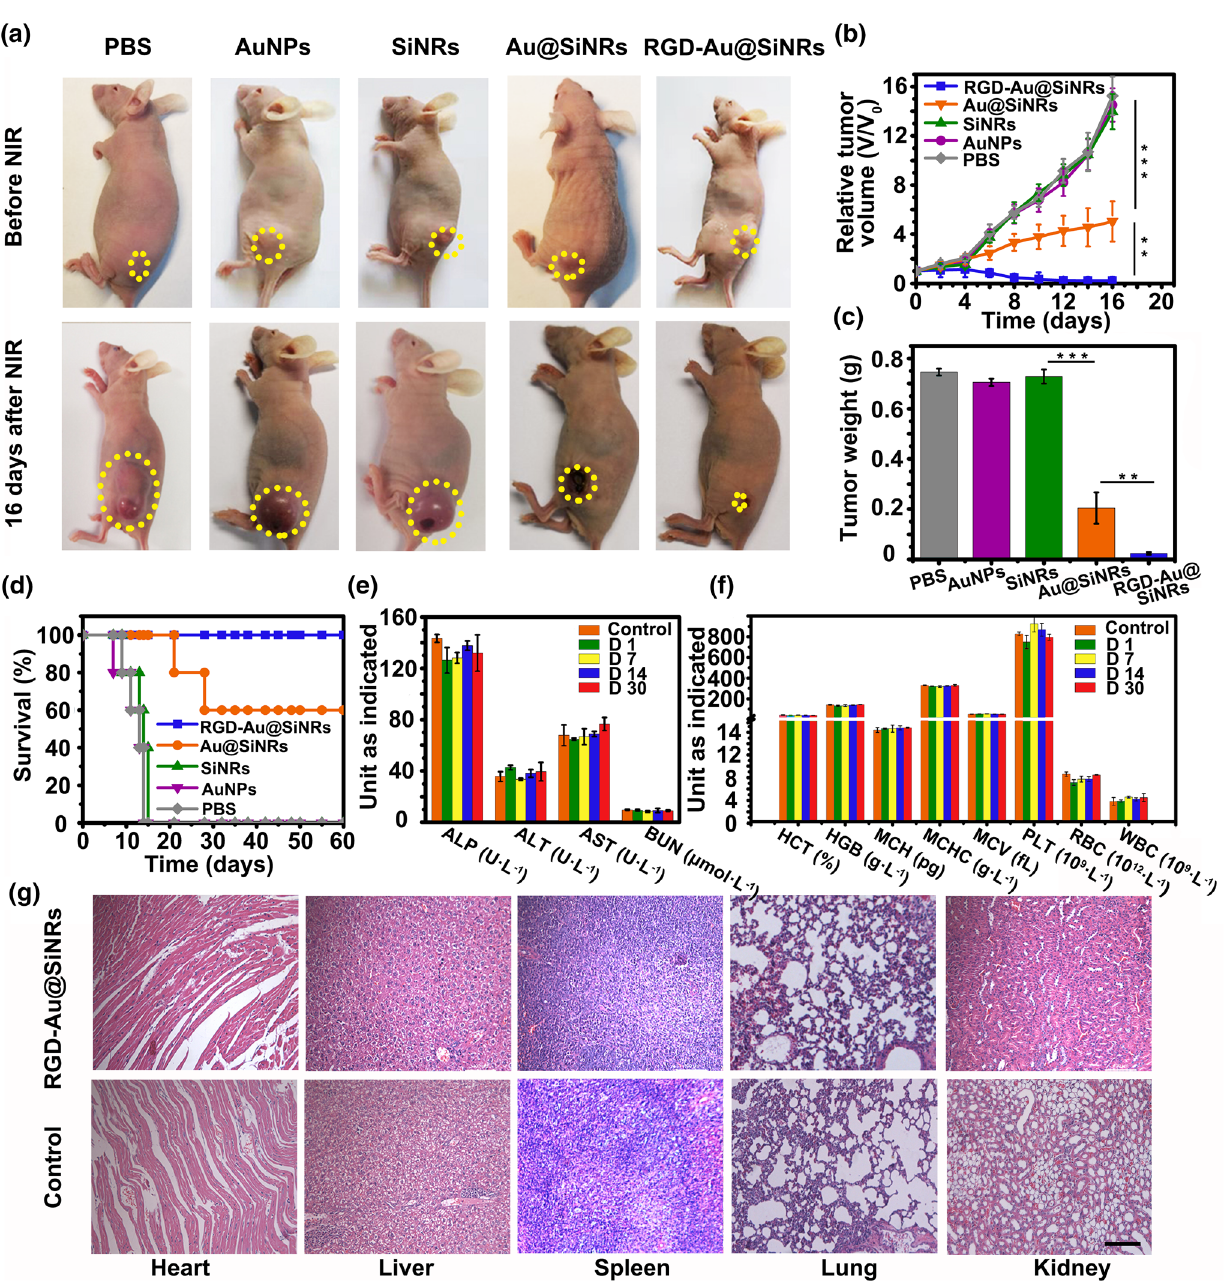
Fig. 5 Photothermal therapy and safety assessment. a Photographs of representative mice before and after the treatment with different agents and NIR irradiation. b Growth curves of tumor volumes of mice groups with NIR irradiation. c Weight of the excised tumors from the PTT- treated mice. d Survival curves of PTT-treated mice. e Serum biochemistry data including alkaline phosphatase, alanine aminotransferase, and aspartate aminotransferase, and blood urea nitrogen levels of control and RGD-Au@SiNRs-treated healthy mice. f Complete blood counts: hem- atocrit, hemoglobin, mean corpuscular hemoglobin, mean corpuscular hemoglobin concentration, mean corpuscular volume, blood platelets, red blood cells, blood levels of white blood cells, and platelets of control and RGD-Au@SiNRs-treated healthy mice. g H&E staining of various organ tissues harvested from tumor-bearing mice at the end of treatment. Asterisk (**) indicates p < 0.01; (***) means p <